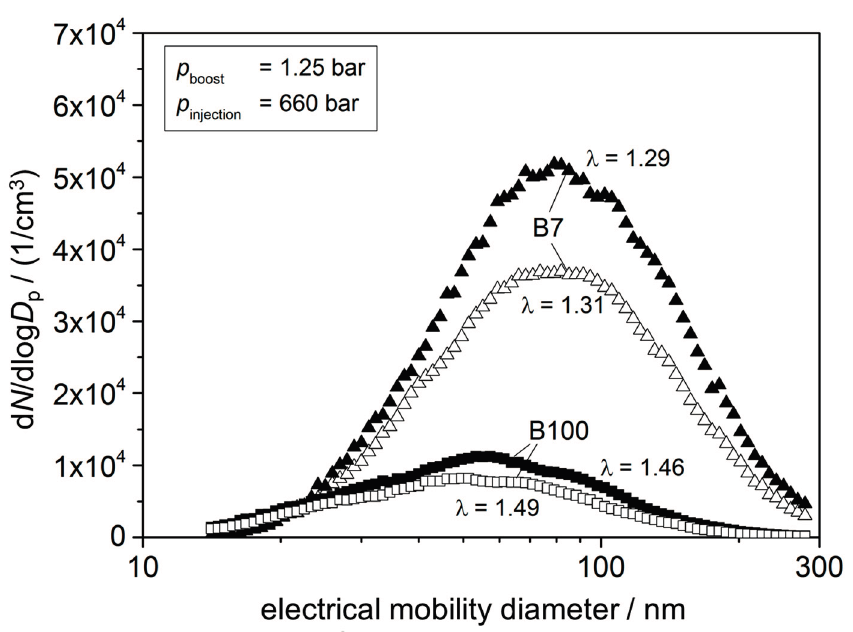
Figure 4. Result of SMPS measurements for different biodiesel content of 7% and 100% at similar engine operation points (1000 rpm; 25% accelerator position; p boost = 1.25 bar; p injection = 660